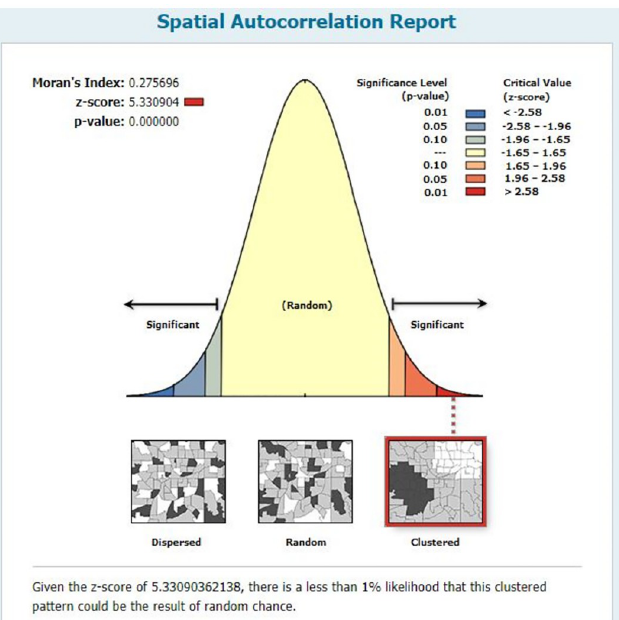
Fig 3. Spatial autocorrelation report of complete basic childhood vaccination among children aged 12–23 months in Ethiopia, EMDHS 2019.